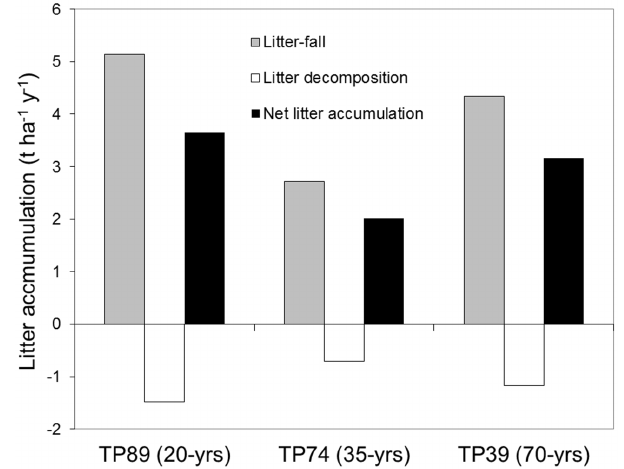
Figure 1. Needle litter decomposition rates over 4 years (2004– 2008) at the three older Turkey Point pine forest sites: TP89, TP74 and TP39 (20, 35 and 70 years old, respectively).